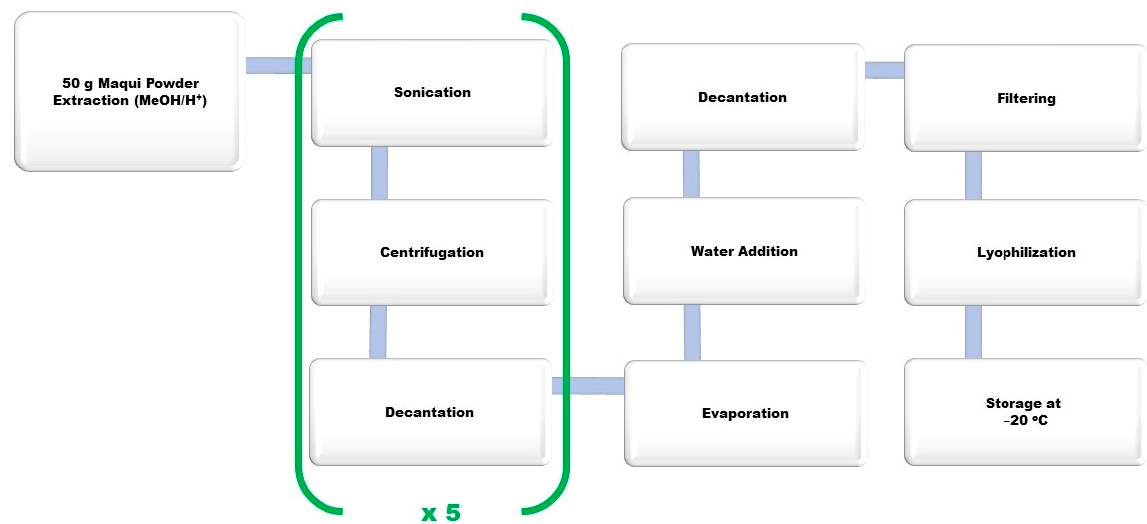
Figure 1. Conceptual scheme of maqui extraction procedure for 50